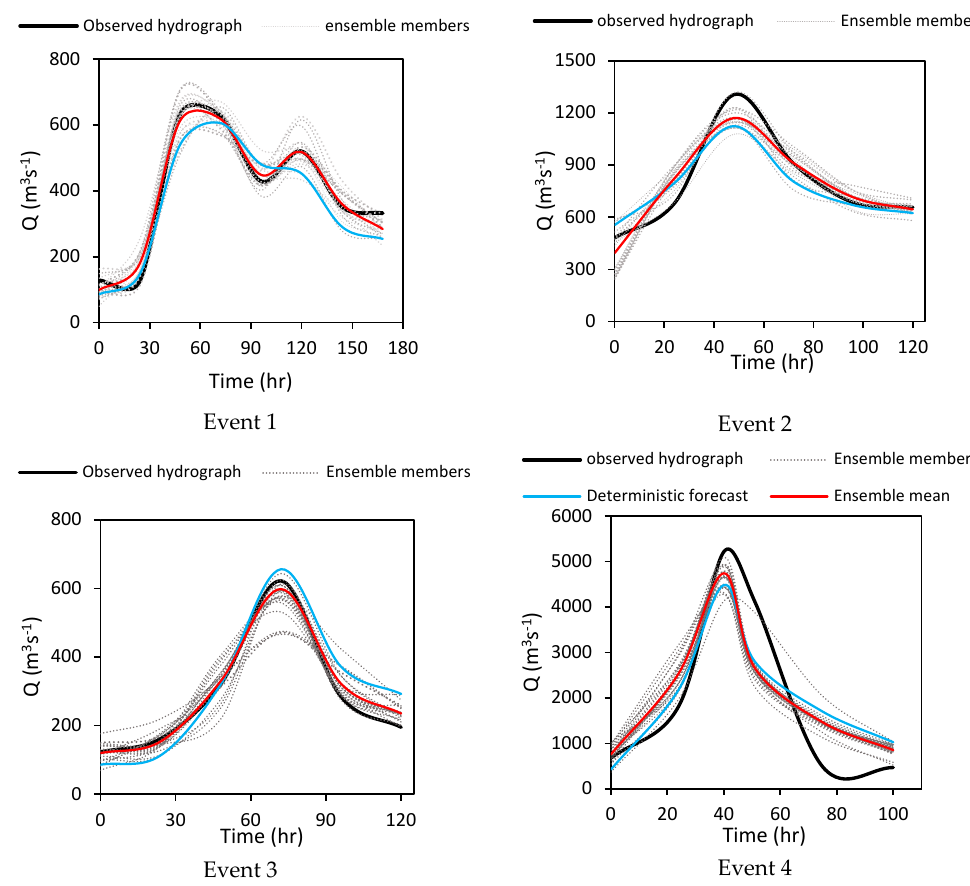
Figure 9. Ensemble reservoir inflow during flood events for the calibration stage. Black lines: observed inflow hydrograph; blue lines: the deterministic inflow forecast based on observed pre- cipitation; grey lines: ensemble inflow forecasts simulated by post-processed EPFs containing all ensemble members; red lines: ensemble-mean of all